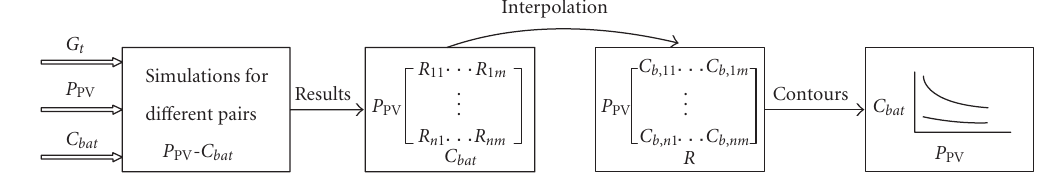
Figure 5: Block diagram of simulation methodology to produce C bat versus P PV